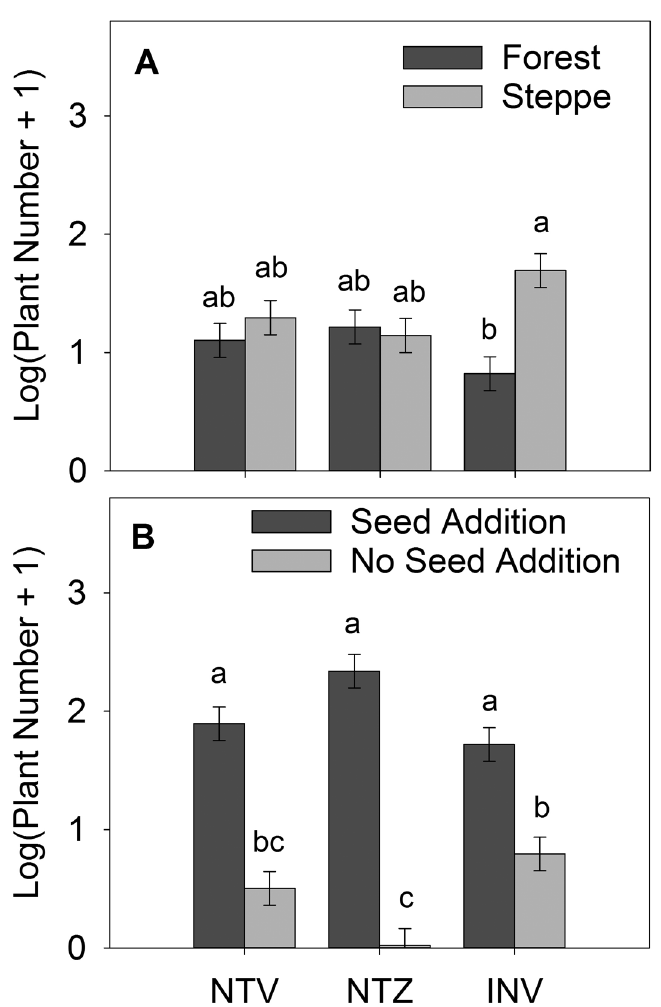
Figure 2. Effect of habitat ( A ) [Forest versus Steppe] and seed addition ( B ) [Seed Addition versus No Seed Addition] on the average number of native (“NTV”), naturalized (“NTZ”), and invasive (“INV”) plants in each plot in July 2012. All plant counts are log(x+1) transformed and responses are reported as least square means estimates ± SE. Post hoc multiple pairwise comparisons were conducted with the Tukey-Kramer method; different lowercase letters indicate significant differences at a Type I error =